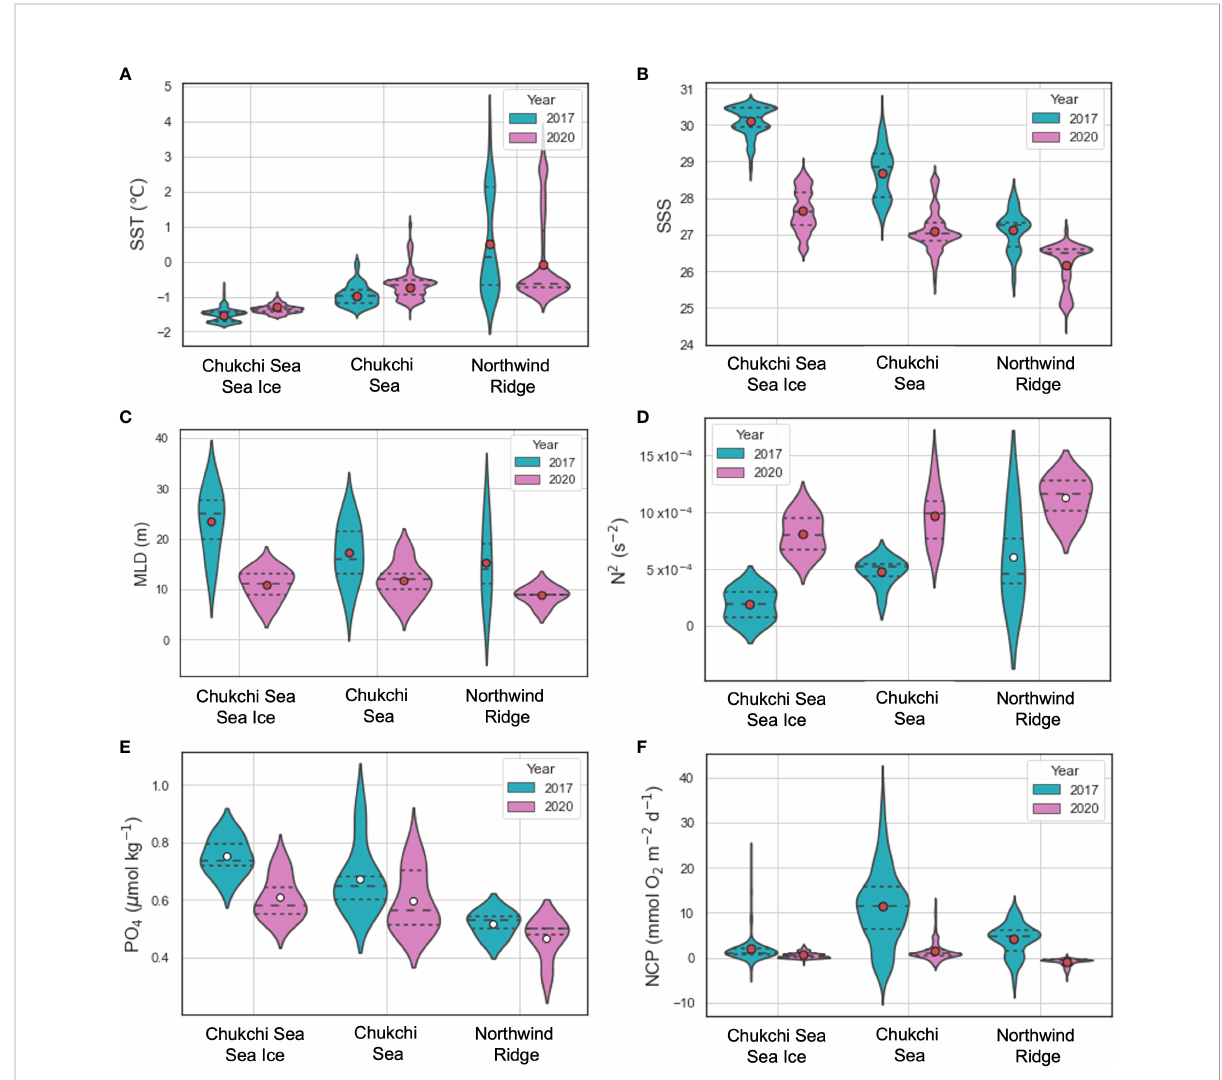
FIGURE 7 Violin plots of environmental parameters (A - E) and NCP (F) for each region. Dotted and dashed lines indicate the 25% – 75% quantiles and medians, respectively. Circles inside violins indicate parameter means. Red circles indicate means statistically different between 2017 and